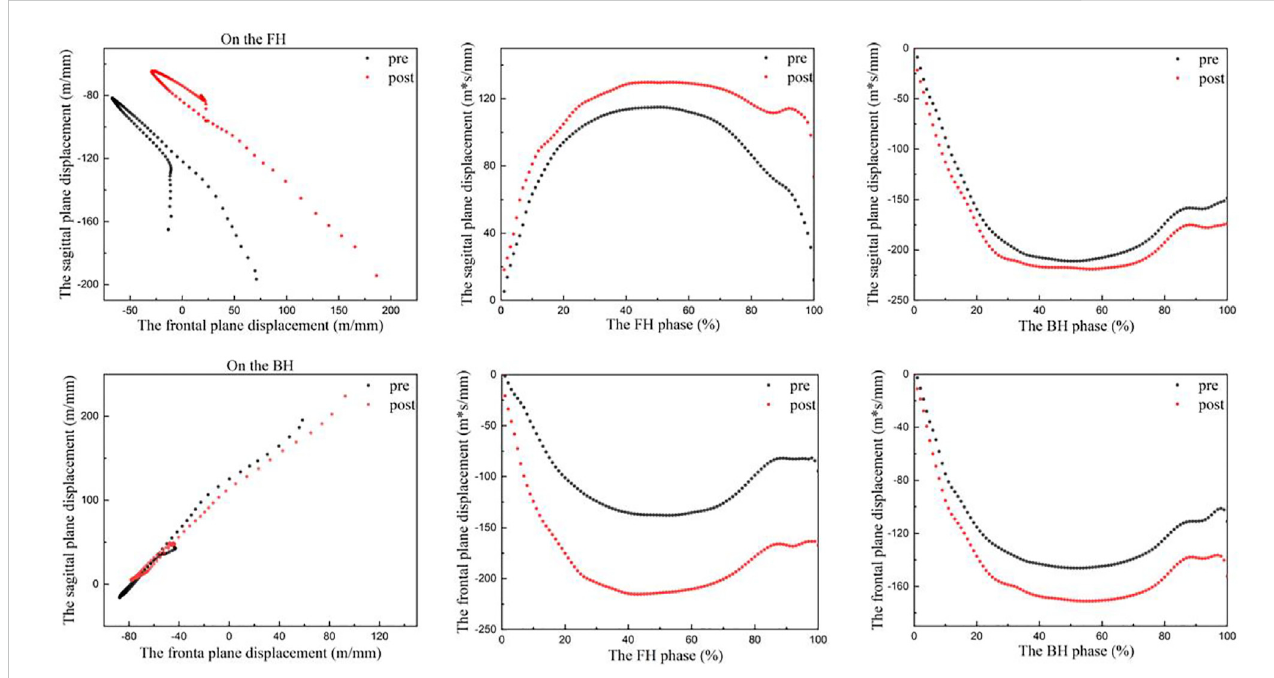
TABLE 3 Comparison of pre-fatigue and post-fatigue means standard deviations for center of pressure displacement characteristics in the FH and BH. Variables FH BH Pre Post t DF Pre Post t DF The Sagittal plane displacement (m*s/mm) 9.98 ± 3.19 The Front plane displacement (m*s/mm)